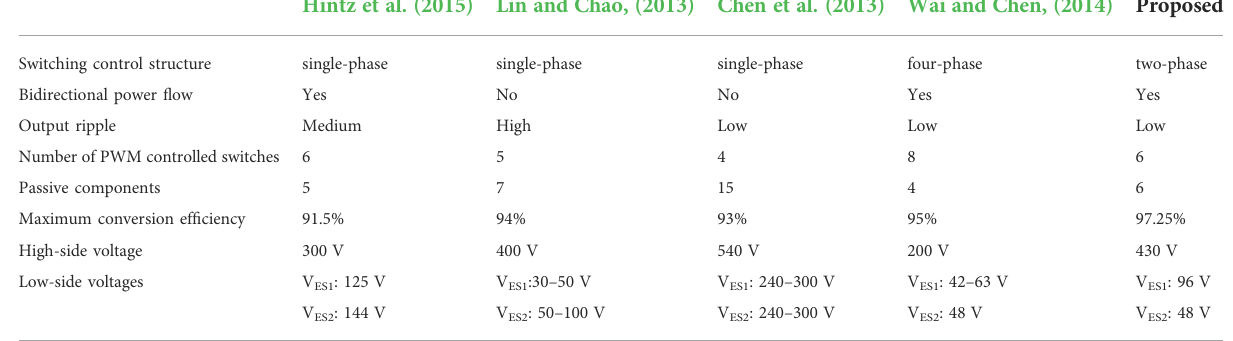
TABLE 3 Illustrating the difference in the performance among a wide range of converters.